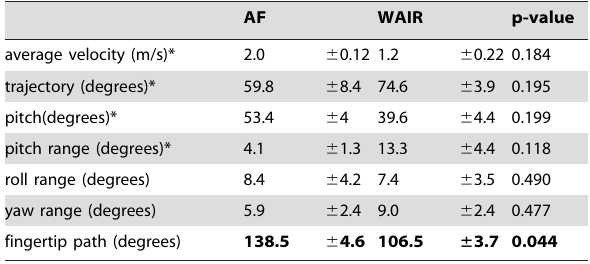
Summary of body movement in global coordinate system